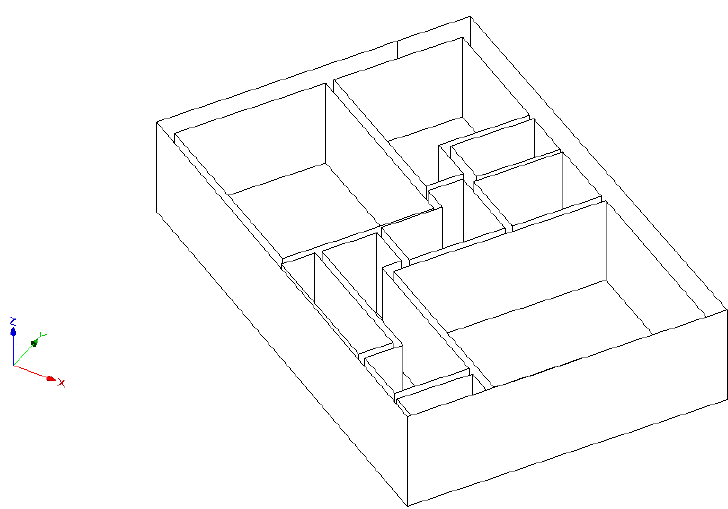
Figure 9. Plan D, extruded models viewed as